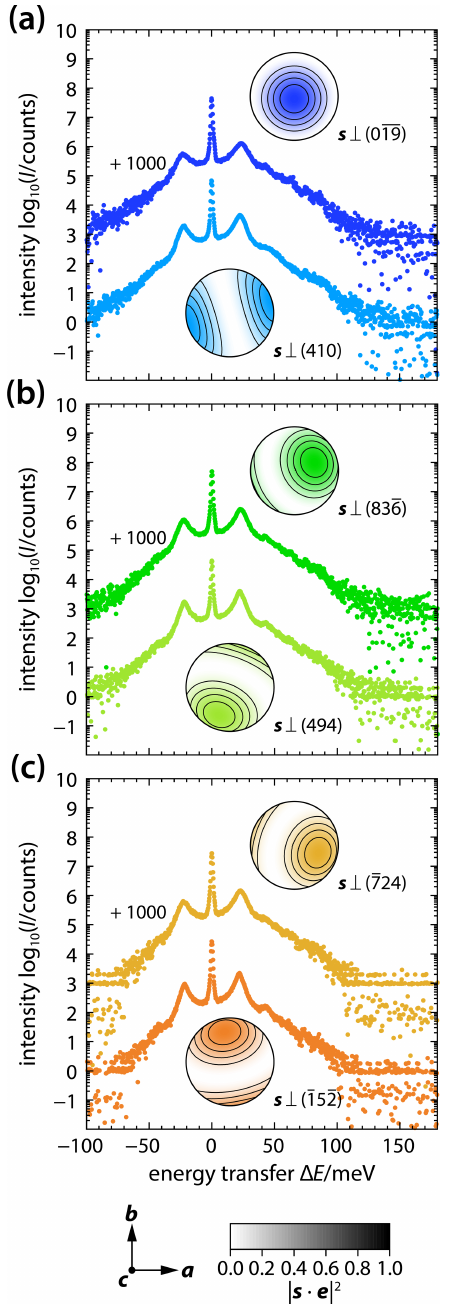
Figure 1. NRIXS spectra of δ -(Al,Fe)OOH single crystals X1 (a) , X2 (b) , and X3 (c) . For each crystal, spectra were recorded with the X-ray beam incident along two different directions s . Vibra- tional modes that displace resonant 57 Fe atoms in the direction e are sampled according to the product | s · e | 2 . For each spectrum, the stereographic projection shows the magnitude of the product | s · e | 2 as a function of the polarization vector e . The orientation of stere- ographic projections is indicated by the crystallographic coordinate system at the bottom. Spectra are vertically offset as indicated for clarity and to demonstrate the high statistical quality of the